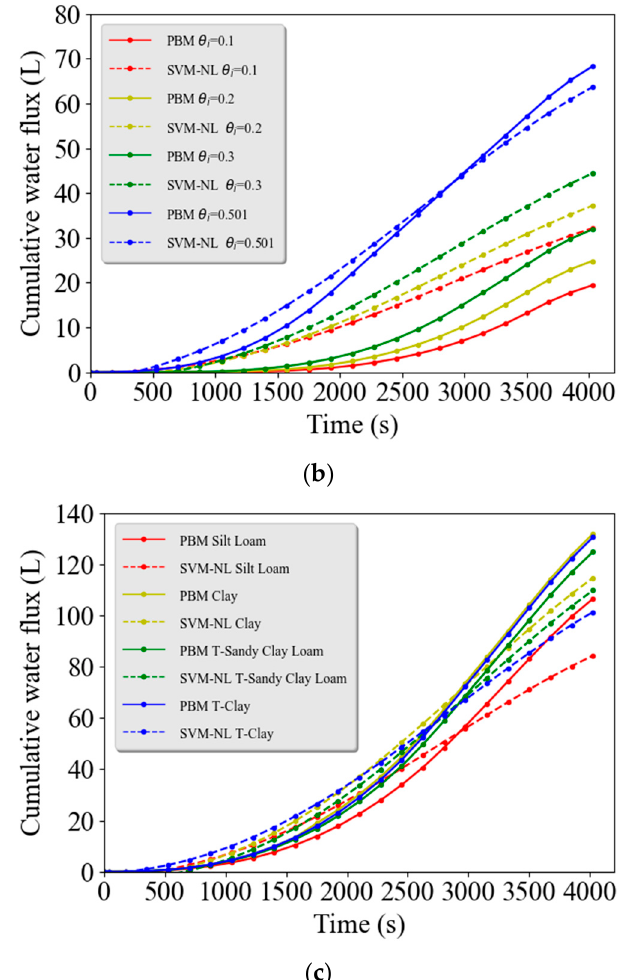
Figure 5. Comparison of cumulative water fluxes ( Q c in liters, L) calculated by the PBM and the Nonlinear Support Vector Machine (SVM-NL) model (( a ) overall, ( b ) different initial water contents, ( c ) different textures)).